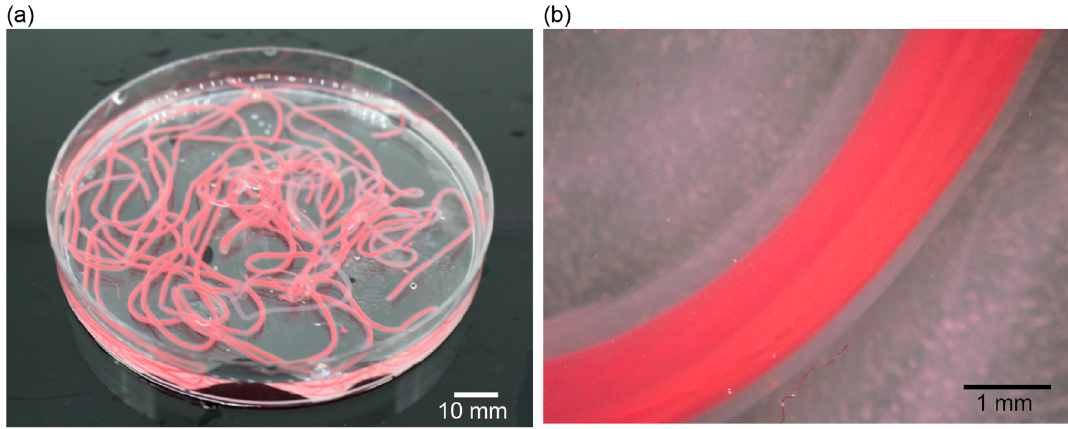
Figure 7. ( a ) Photo of the produced hydrogel microtube with the triple-coaxial device. ( b ) Photomacrogragh of the hydrogel microtube.